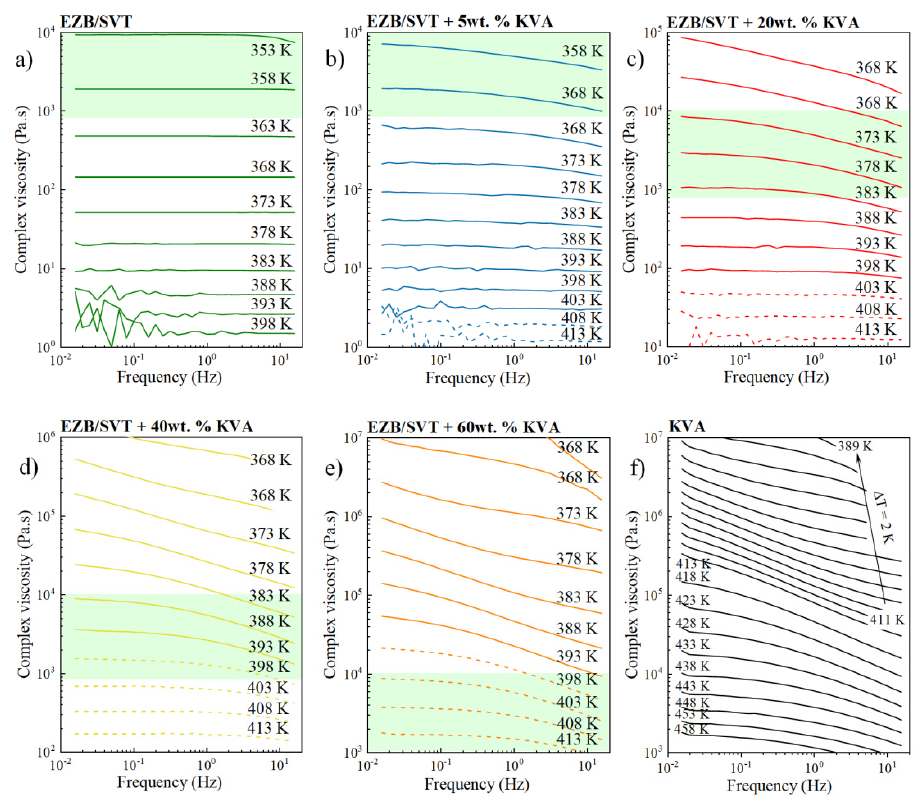
Figure 7. Temperature sweep data showing complex viscosity as a function of frequency of ( a ) the binary amorphous EZB/SVT system, ( b ) the ternary amorphous system of EZB/SVT + 5wt.% KVA, ( c ) the ternary amorphous system of EZB/SVT + 20wt.% KVA, ( d ) the ternary amorphous system of EZB/SVT + 40wt.% KVA, ( e ) the ternary amorphous system of EZB/SVT + 60wt.% KVA and f ) the neat KVA polymer.